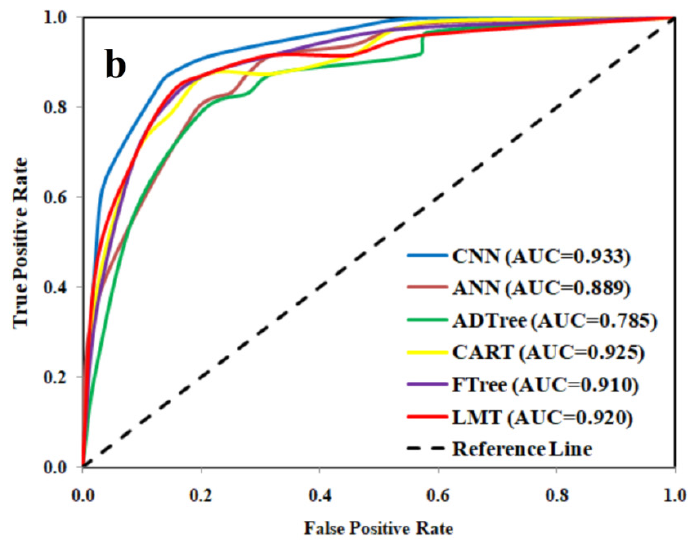
Figure 11. Area under the success rate curve and prediction rate curve for different models: ( a ) training and ( b ) testing. Table 5. Accuracy statistics and prioritisation of models.